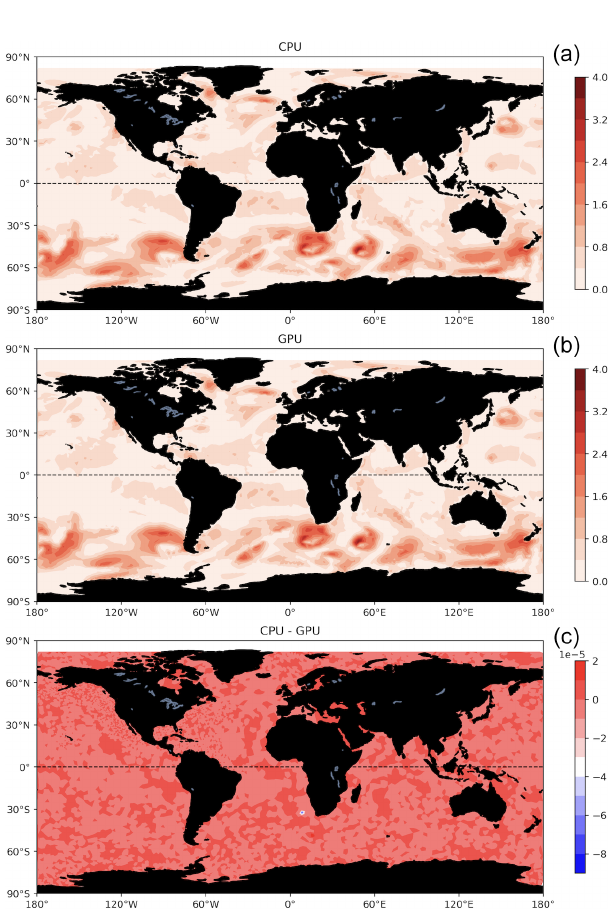
Figure 7. The average of WW3.cpu (a) and WW3- W3SRCEMD.gpu (b) last 2h simulations and their differences (c) for significant wave